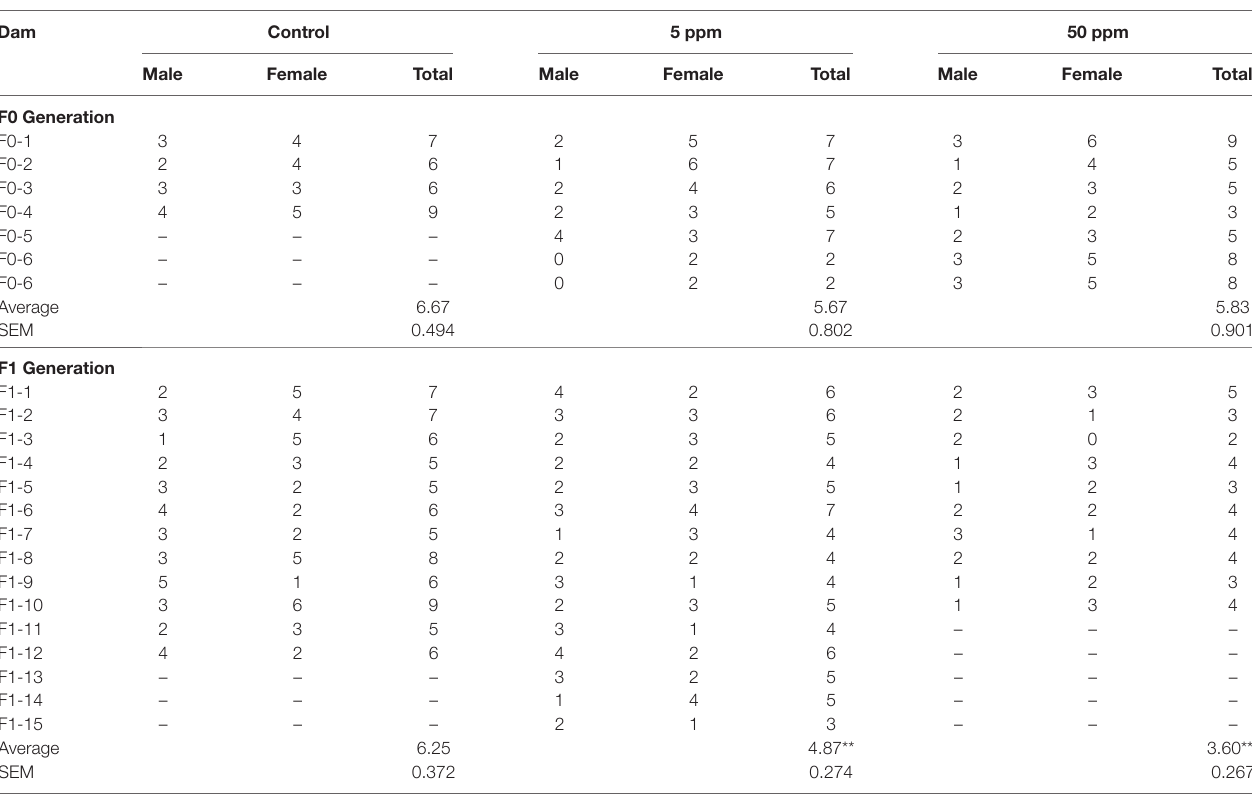
TaBle 1 | Number of offspring from individual